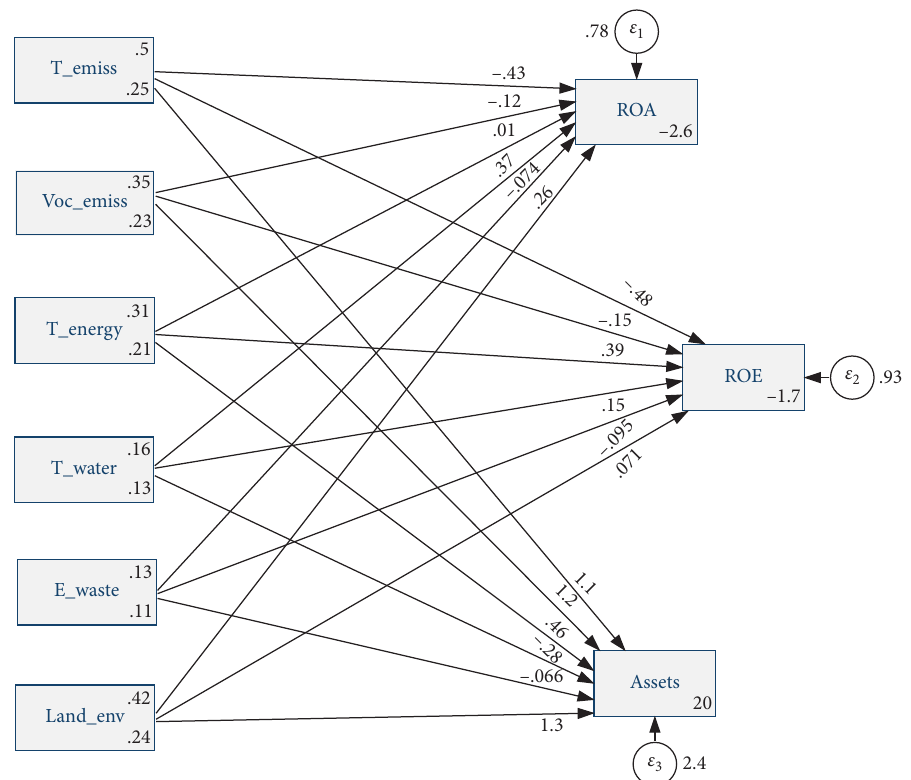
Figure 3: The association between targets measures and the financial performance (SEM), for oil and gas companies from the EEA, 2009–2018. Source: own contribution in Stata